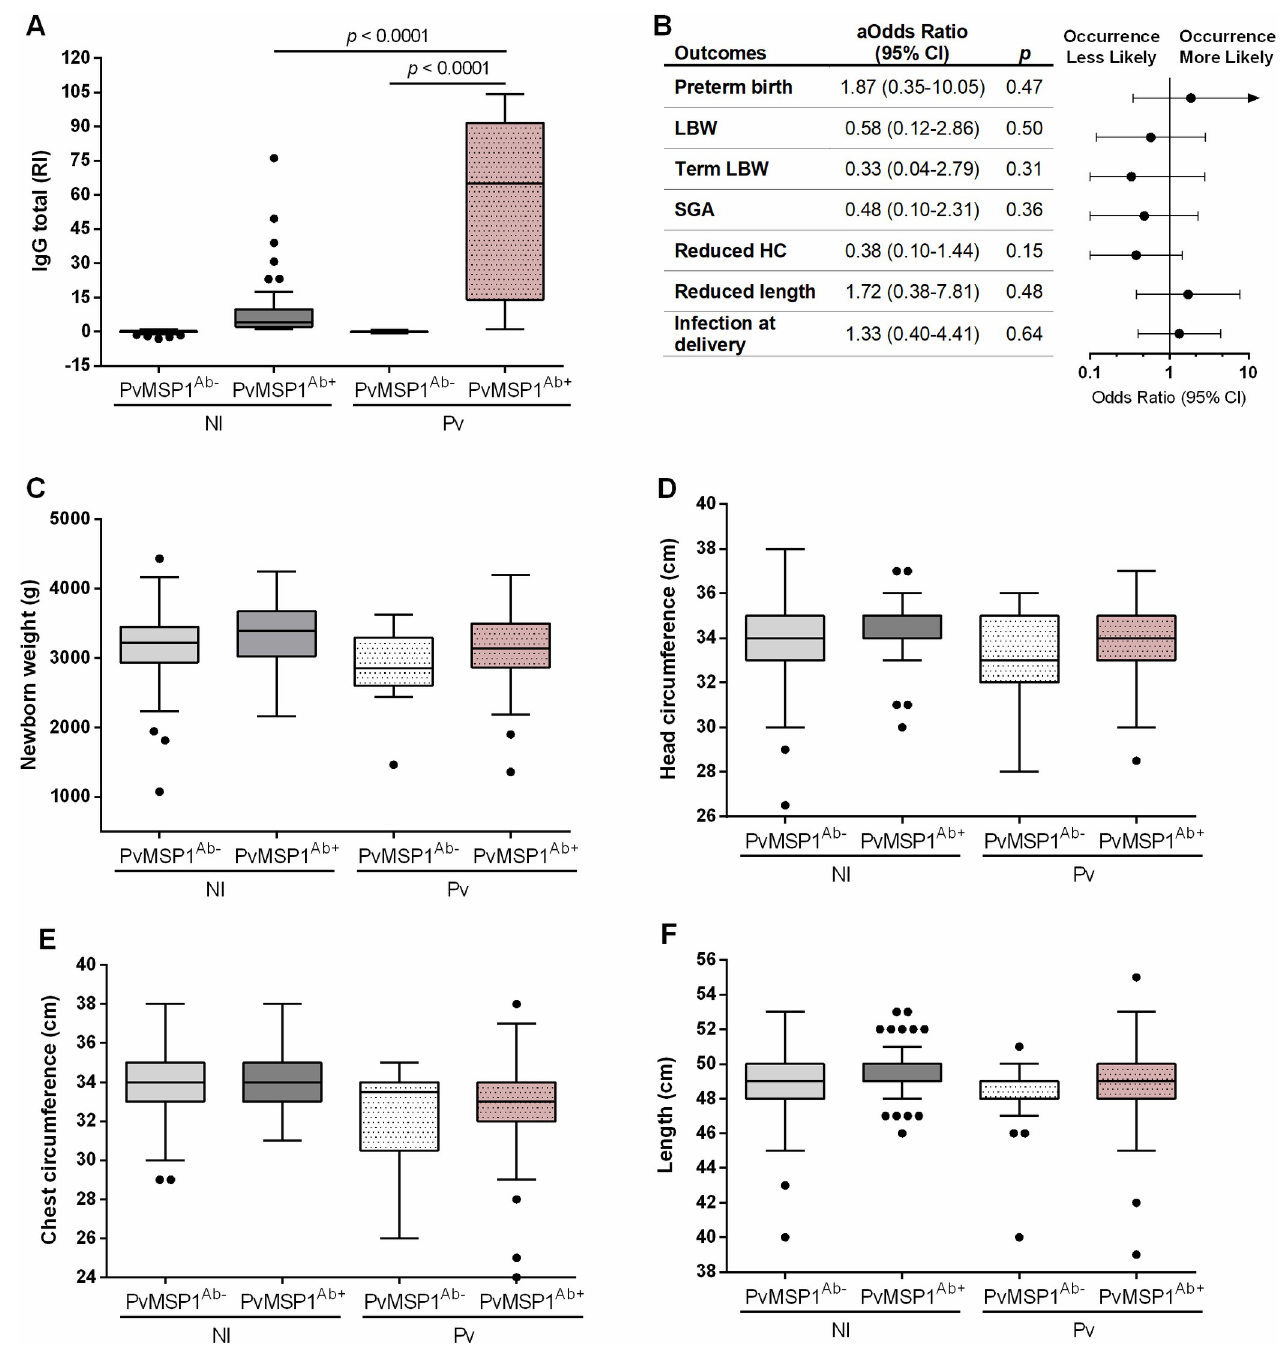
Fig 5. Anthropometric measurements of newborn, according to previous exposure to P . vivax (PvMSP1). (A) Antibody profile among non-infected and P . vivax -infected pregnant women; (B) Forest plot of odds ratios of adverse pregnancy outcomes in infected women with anti-PvMSP1 IgG compared with infected women without anti-PvMSP1 IgG; (C) Newborn weight; (D) Head circumference; (E) Chest circumference; and, (F) Length. NI-PvMSP1 Ab- —non- infected non-exposed (N = 106–112); NI- PvMSP1 Ab+ —non-infected exposed (N = 54–58); Pv- PvMSP1 Ab- — P . vivax -infected non-exposed (N = 19); Pv- PvMSP1 Ab+ — P . vivax -infected exposed (N = 80–95). PvMSP1- Plasmodium vivax merozoite surface protein 1; Ab—Antibody; LBW—low birth weight; SGA —small for gestational age; HC—head circumference. RI—Reactivity indices were calculated as the ratio between each test sample’s corrected absorbance values and a cut-off value for antigen, corresponding to the average corrected absorbance of samples from 10 malaria-na ï ve blood donors plus 3 standard deviations. Weight in grams (g). Head and chest circumferences, and body length in centimeters (cm). Data are represented as Tukey boxplots, with the bottom and top of each box representing the first and third quartiles; the line inside the box is the median, and the whiskers represent the lowest and the highest data within 1.5 IQR of the first and upper quartiles; and the circles, outliers. Odds ratios were adjusted (aOR) for maternal age, gravidity status,